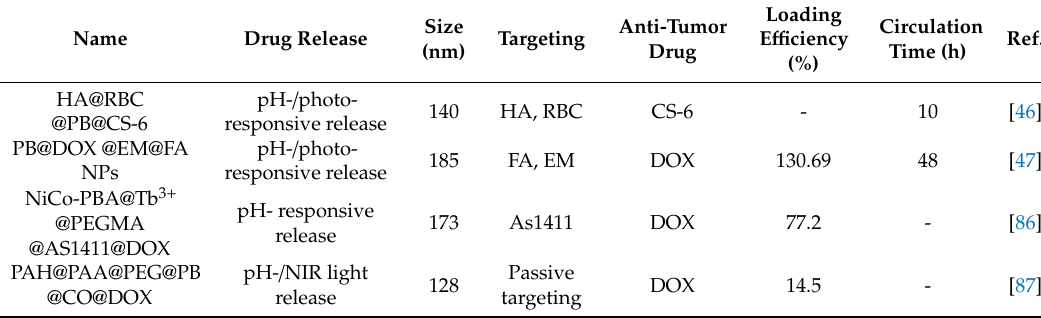
Table 2. Summary of PB-based nanoparticles for drug